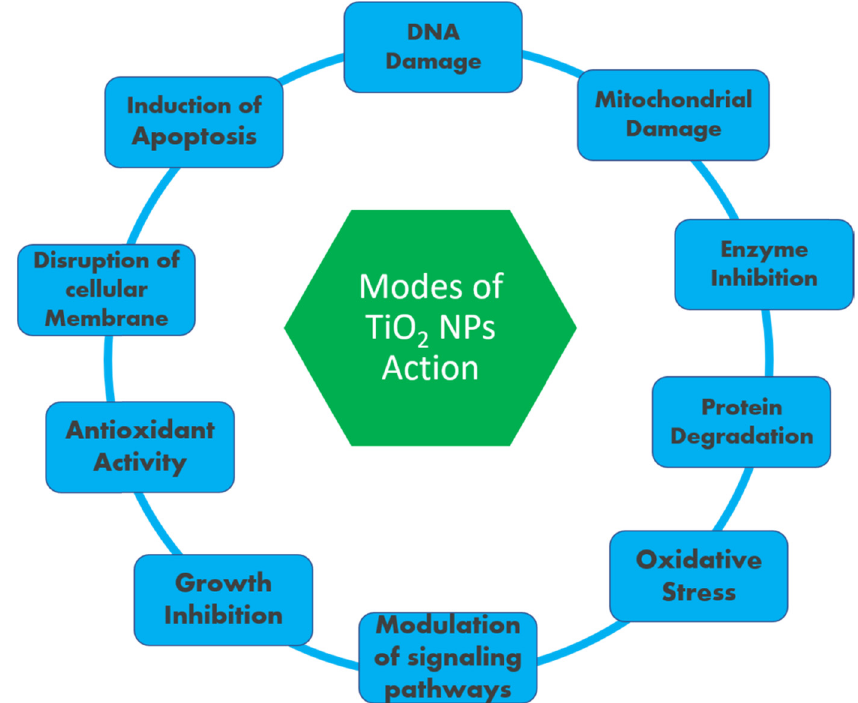
Figure 6: Di ff erent modes of action of TiO 2 -